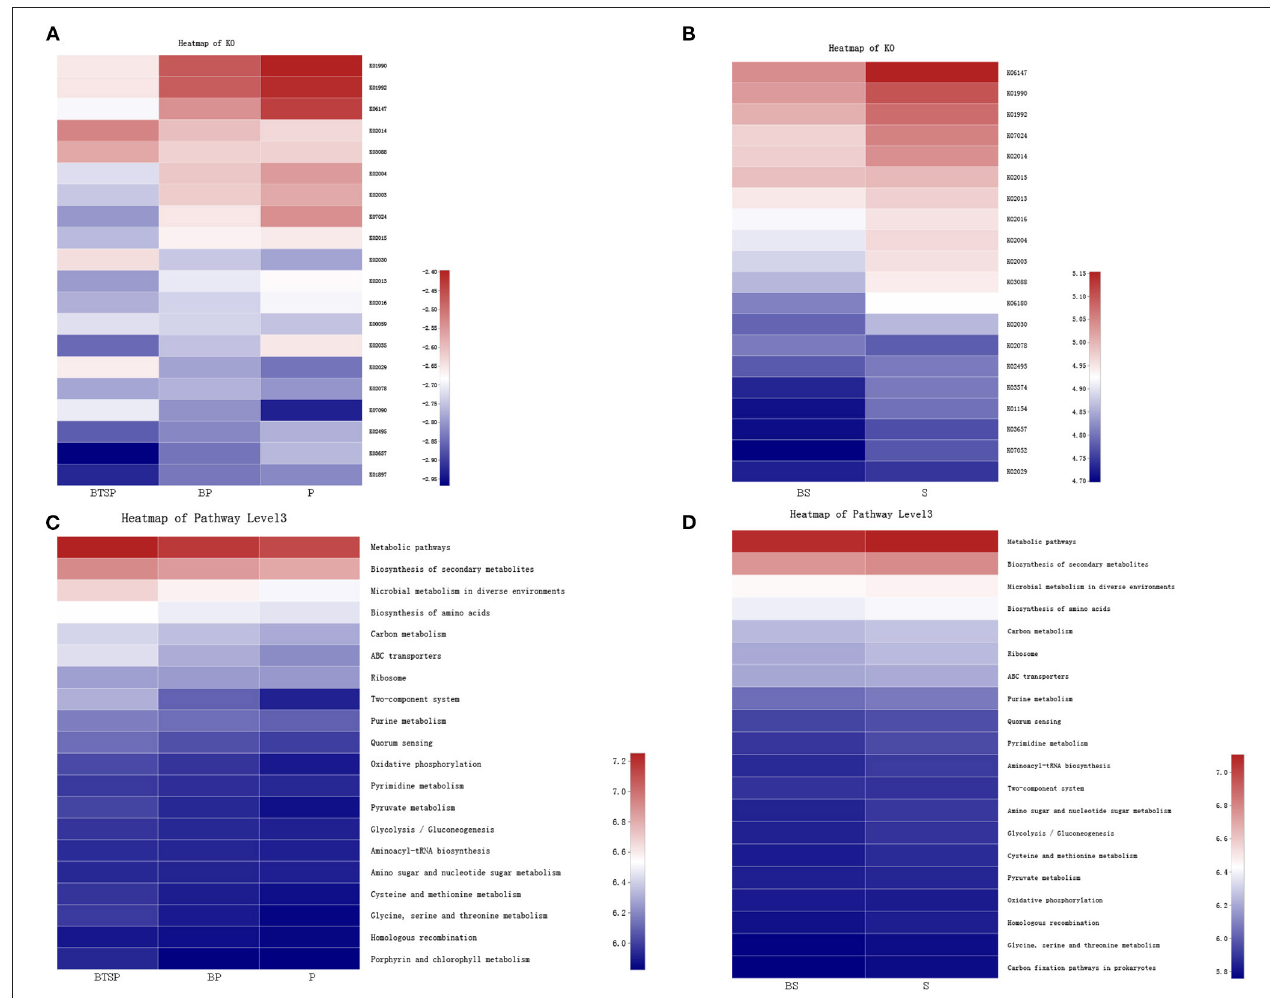
FIGURE 5 | Metabolism alterations in the microbiome. The color in the heatmap represents the relative abundance according to the right panel: (A) Predicted functional profile with KEGG Orthology (KO) in plaque samples. (B) KO of saliva samples. (C) KEGG pathways (level 3) in plaque samples. (D) KEGG pathways (level 3) in saliva